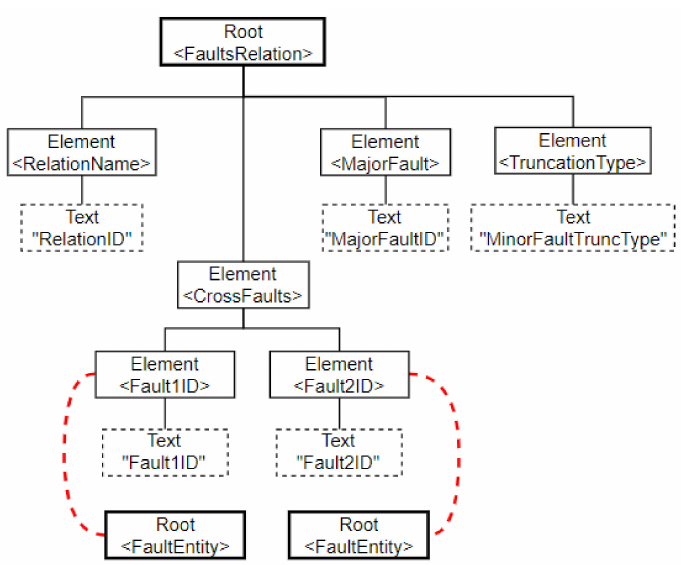
Figure 16. Schematic diagram of XML description template of complex fault